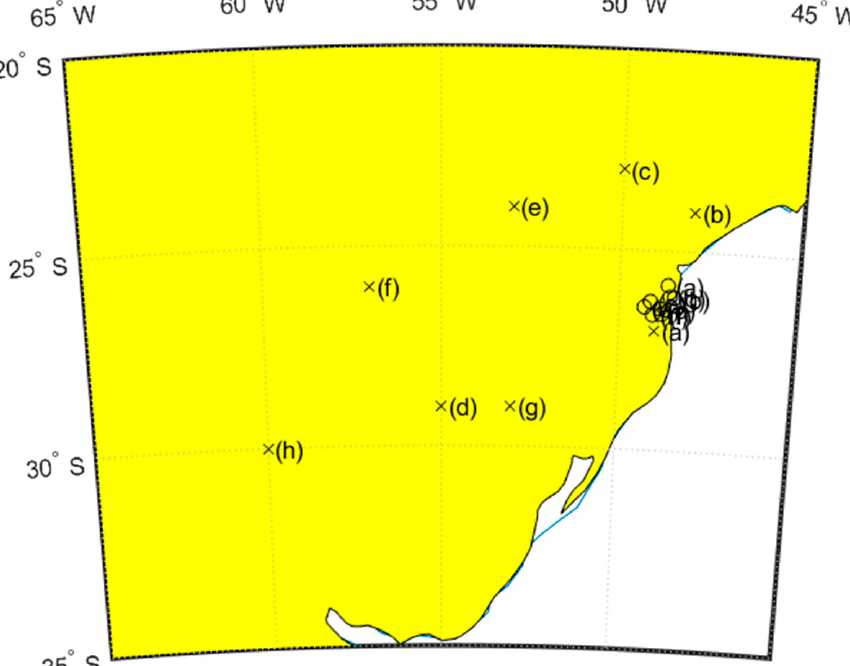
Figure 9. Development of the SAA centroid. The development of the position of the centroid was interpolated by a first-order polynomial (straight line), as shown in Figure 10. The resulting polynomials for latitude (cid:2019) (cid:3007) and longitude (cid:2030) (cid:3007) are as follows: (cid:2019) (cid:3007) = (cid:3398)0.00093(cid:1856) (cid:3398) 26.0229 (cid:2030) (cid:3007) = (cid:3398)0.00062(cid:1856) (cid:3398) 48.65654 (4) where (cid:1856) is the time in days from the first measurement (30 August 2019).